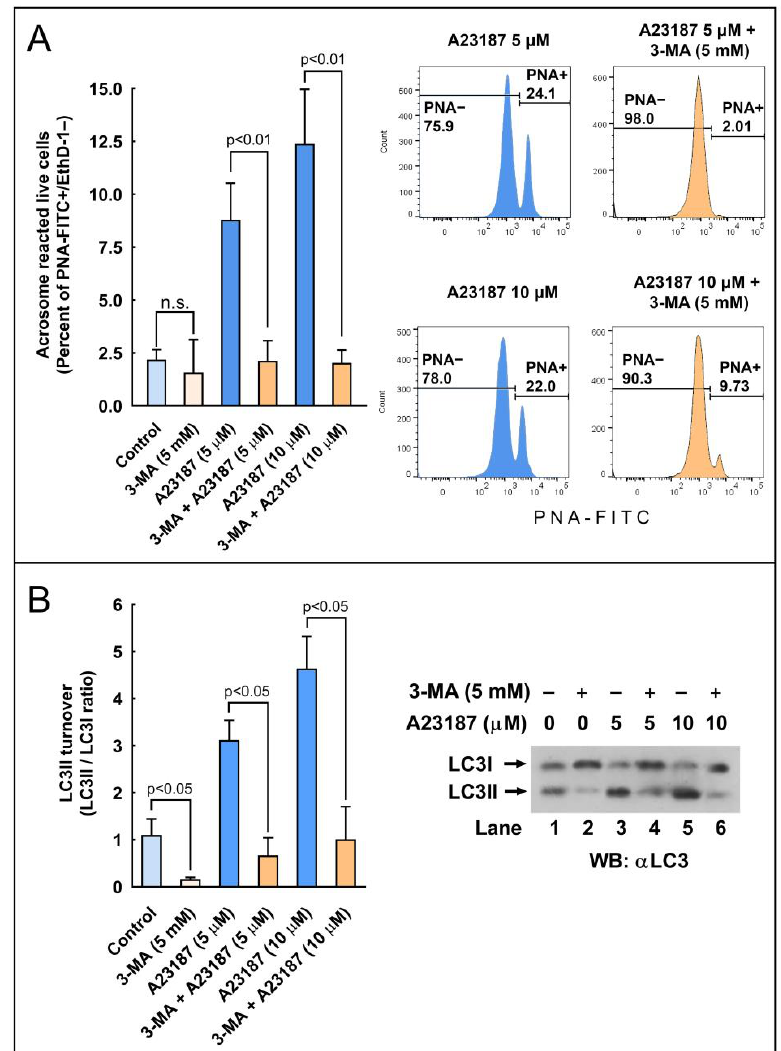
Figure 9. The effect of the autophagy inhibitor 3-methyladenine (3-MA) on the processing of LC3II and the development of the acrosome reaction in stallion sperm cells. ( A ) Stallion spermatozoa were incubated for 210 min in BWW at 37 °C in the presence or absence (control) of 3-MA (5 mM) and then were further incubated for 30 min (final incubation time 240 min) with the vehicle (control), 5 µM A23187, or 10 µM A23187. After incubation, spermatozoa were washed with PBS and labeled with probes to characterize, by flow cytometry, the DNA content (Hoechst 33342), cellular viability (EthD-1), and acrosome reaction (PNA-FITC). Cytometry data were processed as above, performing the analysis by quadrants (graph) or after gating out dead cells (histograms on the right). Results in the graph represent the mean ± SEM of 4 independent experiments expressed as the percentage of acrosome-reacted live sperm cells (Q3 quadrant). A two- tailed Student’s t -test for unpaired samples was applied to compare the mean of each treatment with their respective controls. The significance level is indicated in the figure. ( B ) Stallion spermatozoa were incubated for 4 h in BWW at 37 °C in the presence or absence of 3-MA (5 mM). After incubation, the processing of LC3I to LC3II was assessed by western blotting. LC3 turnover was expressed as the LC3II/LC3I ratio. Values represent the mean ± SEM of 4 independent experiments. A two- tailed Student’s t -test for unpaired samples was applied to compare the means of each group with the significance level set at 0.05, as is indi- cated in the figure. In the right part of the figure, there is a representative immunoblotting of three other independent experiments.